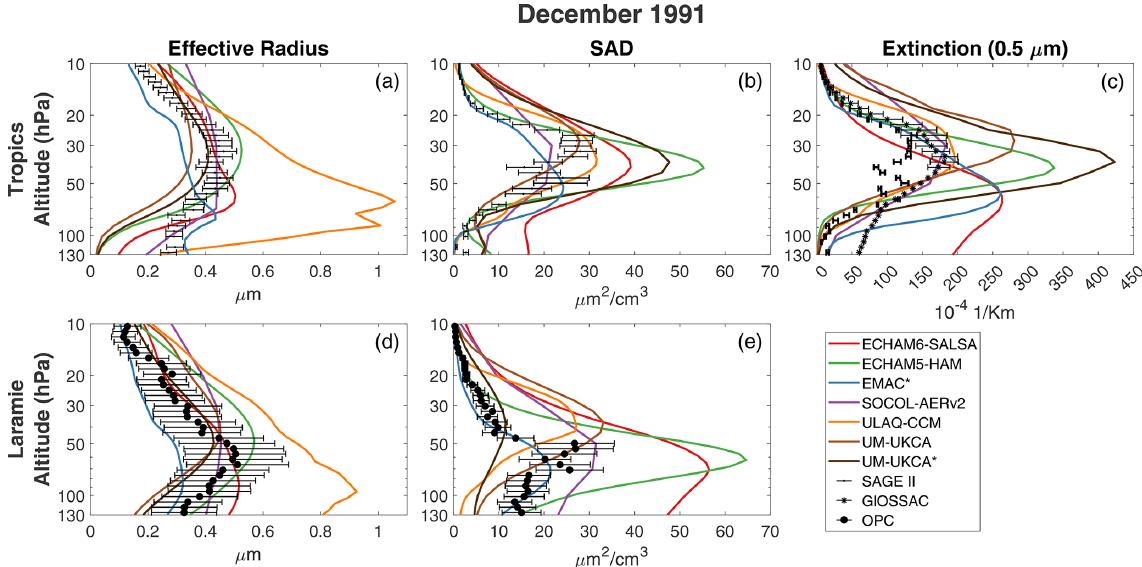
Figure 9. Vertical profile of the effective radius in micrometers (a, d) , surface area density (SAD) in square micrometers per cubic centimeter (b, e) , and extinction at 0.5µm in km − 1 (c) in the tropics (a–c) and over Laramie (d–e) for Med-22km in December 1991. Model results are compared with SAGE II and GloSSAC in the tropics and with OPC over Laramie. ∗ Models with spatially spread SO 2